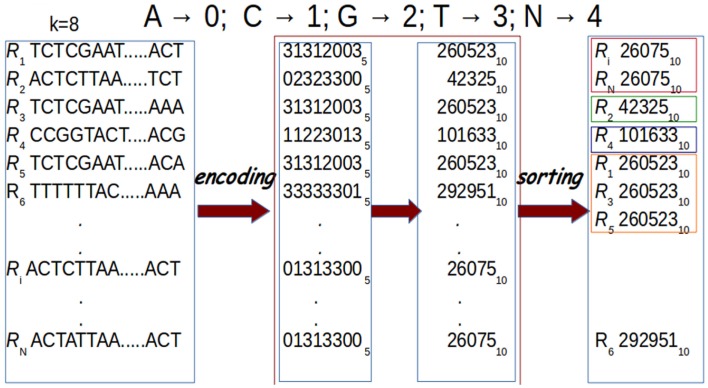
Prefixes are subject to a dual encoding. As for the first encoding, each nucleotide in a prefix is represented with a numerical value from 0 to 4 (A → 0, C → 1, G → 2, T → 3, N → 4). Then, these numerical representations are encoded using base-10. Finally, sorting is performed for clustering. In the figure, prefixes of length k = 8 are represented.